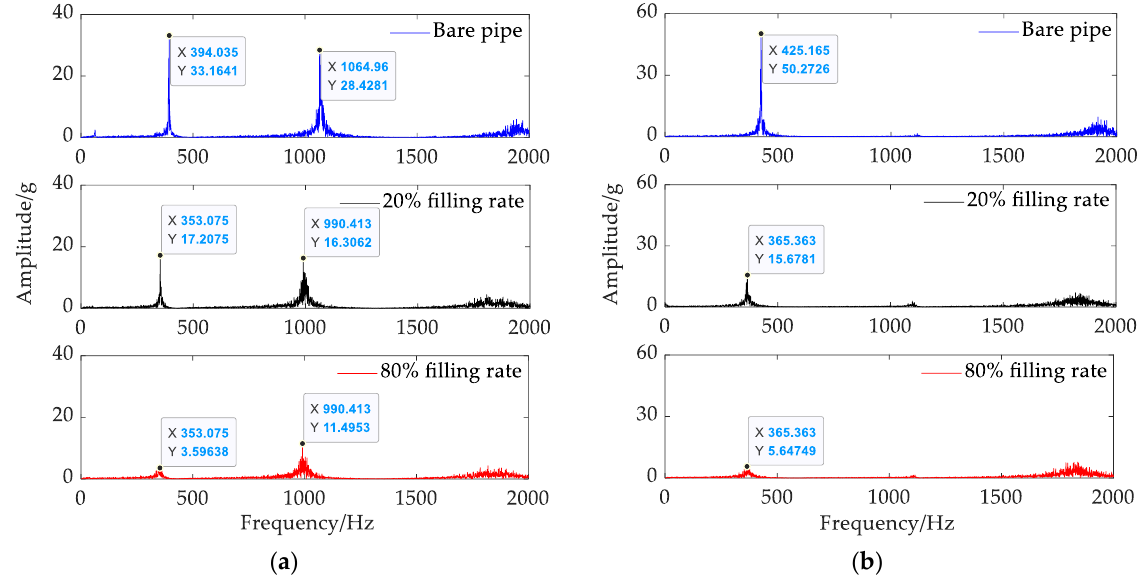
Figure 18. Comparison of damping performance with different boundary conditions; ( a ) fix-free, ( b ) fix-fix boundary condition.